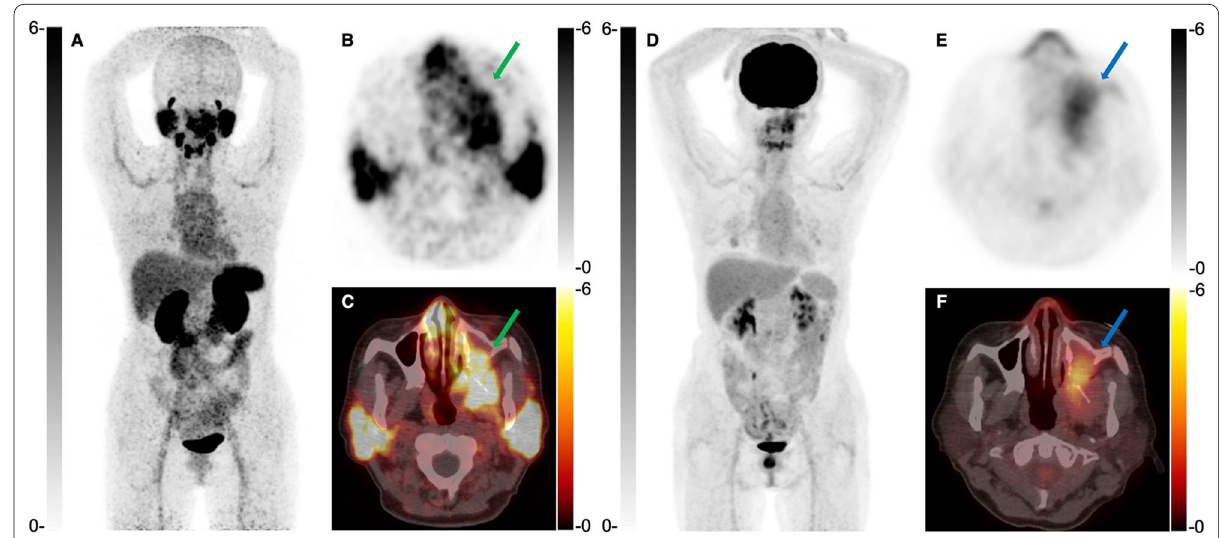
Fig. 2 A 53-year-old female patient with primary ACC. Anterior maximum intensity projection (MIP) and axial 68 Ga-PSMA PET/CT ( A – C ) showed increased tracer uptake of the tumor in the left maxillary sinus (green arrow, SUVmax 9.8). 18 F-FDG PET/CT ( D – F ) showed a lower uptake (blue arrow, SUVmax